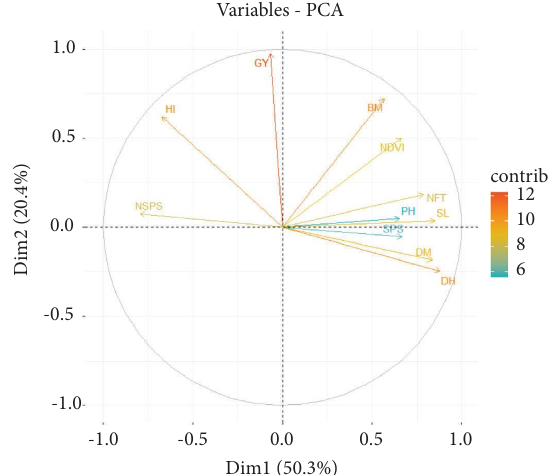
Figure 9: Phenotypic correlations among phenological, yield and its components, and physiological traits of 200 durum wheat ge- notypes tested under low N conditions at three